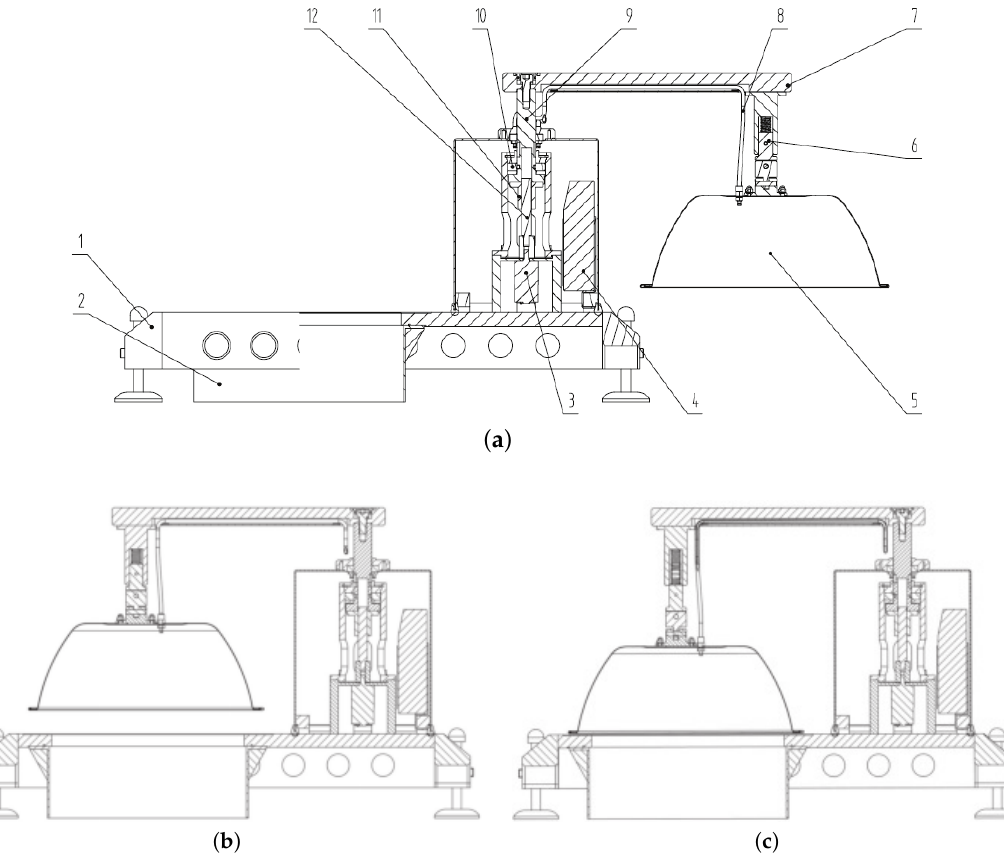
Figure 4. Mechanical structure of SCFSen . ( a ) During interludes between measurements. 1—base frame; 2—fixing ring; 3—motor; 4—controlling module; 5—chamber cover; 6—buffered connecting rod; 7—rocker arm; 8—pipe; 9—track connecting rod; 10—rocker pin; 11—sleeve; 12—motor connecting rod. ( b ) Before measurements. ( c ) During